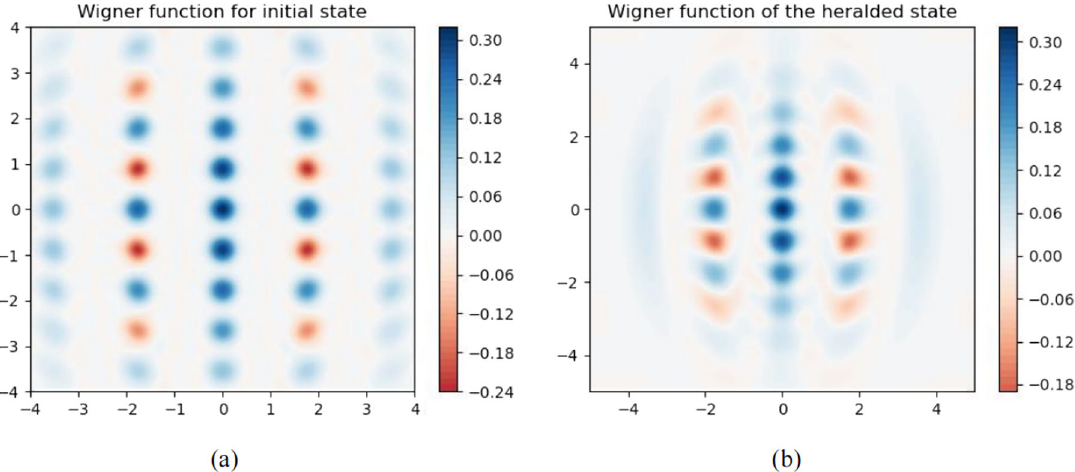
Fig. 1 Schematic diagram of GKP states with fi ve photon numbers. a The left image is the calculated ground state 0 gkp approximate GKP quantum state with an average photon number n ¼ 5 . b The right image is a GKP quantum state with an average photon number computational ground state 1 gkp